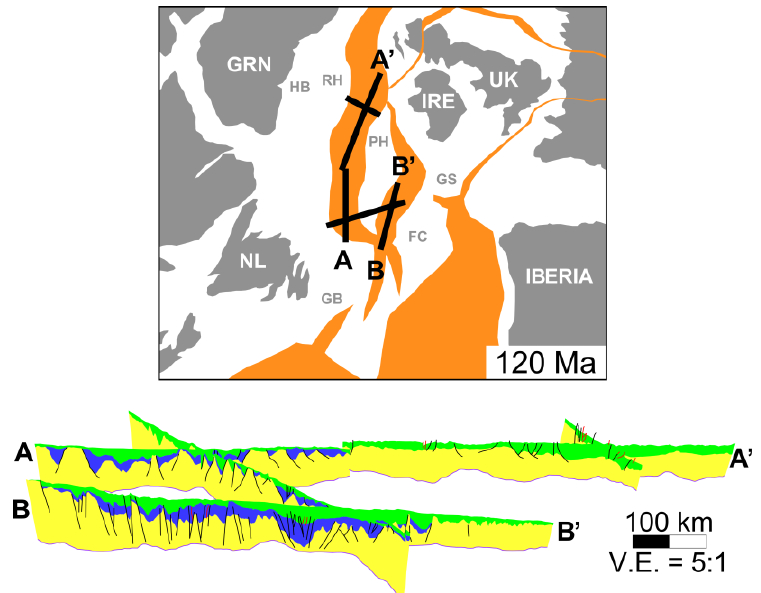
Figure 12. Simplified map of reconstruction from [24] at 120 Ma showing modern landmasses (gray), rifts (orange), and locations of the investigated seismic lines (thick black lines) above a 3D reconstruction with profile A to A’ connecting seismic lines NL1 and IR1 and profile B to B’ representing seismic line NL3. Black lines represent primary faults and red lines represent secondary faults. For meaning of layer colours, see legend in Figure 6.